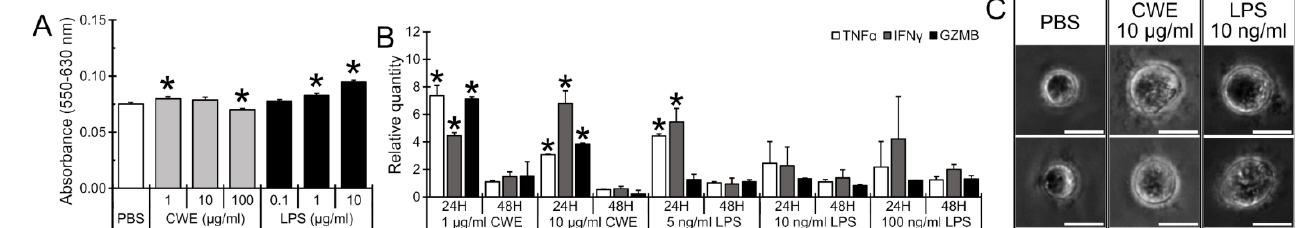
Figure 5. CWE treatment increased cytokine expressions and induced morphological differentiation in Jurkat cells. ( A ) Cell proliferation of Jurkat cells was evaluated by MTT assay in the presence or absence of CWE (1 – 100 µg/mL) or LPS (0.1 – 10 µg/mL) at 48 h after the treatment ( n = 3). ( B ) T cell activation-associated cytokine expression in Jurkat cells treated with 1 or 10 µg/mL CWE, or 5, 10, or 100 ng/mL LPS at 24 and 48 h after treatment was measured by RT-qPCR. *, p < 0.05 compared to PBS control group ( n = 4). ( C ) The Jurkat cells were grown in a U-shaped agar matrix (Day 0). The CWE (10 µ g/mL) or LPS (10 ng/mL) was treated twice at Day 1 and Day 4. Typical pictures of CWE- or LPS-treated Jurkat cells in the agar matrix at Day 7. Scale bar, 20 µ